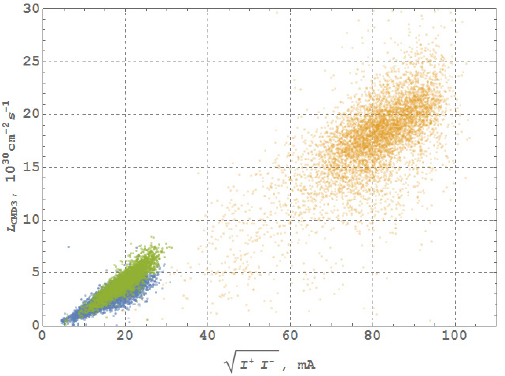
Fig. 6 The CMD-3 recorded luminosity as a function of beam currents. Blue and green dots correspond to machine performance in 2013 with short and long bunch correspondingly. Yellow dots correspond to